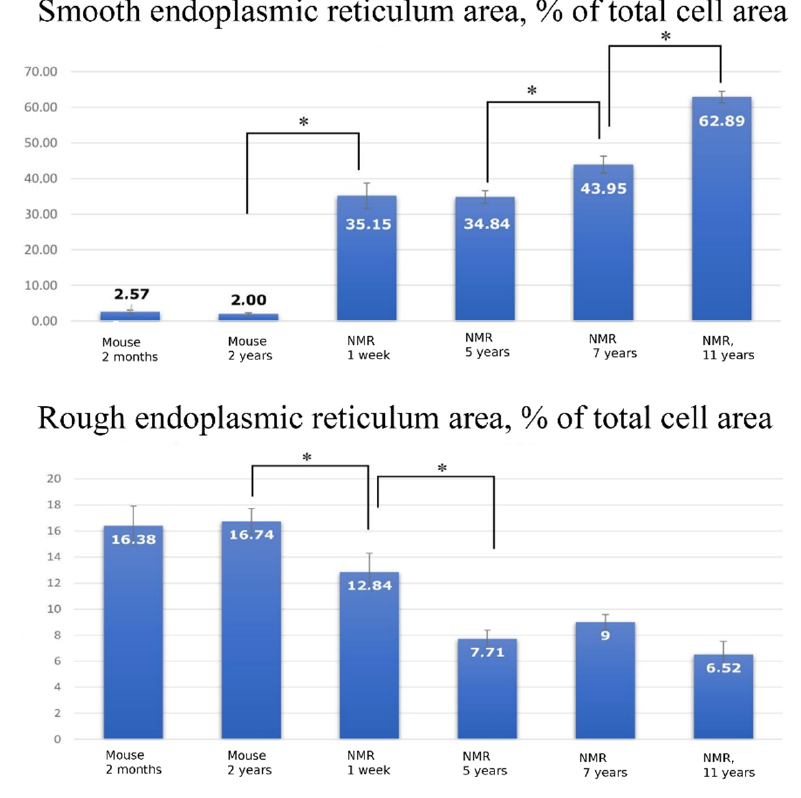
Figure 7. ( Top ) Proportion of SER area relative to total cell area (%) in the hepatocytes of C57BL/6 mice aged 2 months and 2 years, and H. glaber aged 1 week, 5 years, 7 years, and 11 years. ( Bottom ) Proportion of RER area relative to the total cell area (%) in the hepatocytes of C57BL/6 mice aged 3 months and 2 years, and H. glaber aged 1 week, 5 years, 7 years, and 11 years. * The difference is significant at p < 0.05. Error bars on all the graphs correspond to the standard error.